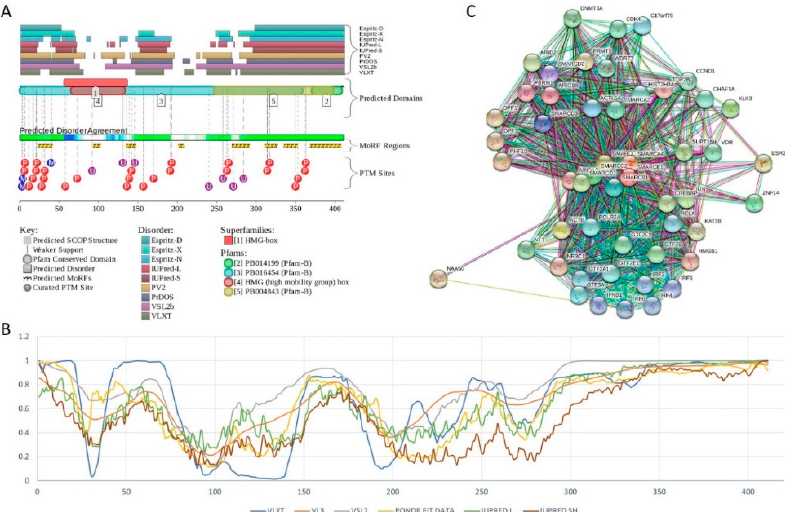
Figure 12. Structural and functional analysis of the human BAF57 protein (UniProt ID: Q969G3). ( A ) D 2 P 2 functional disorder profile of human BAF57 protein. ( B ) Intrinsic disorder profile of human BAF57 protein generated by six commonly used predictors of intrinsic disorder (PONDR ® VLXT, PONDR ® VL3, PONDR ® VSL2, PONDR ® FIT, IUPred_short, and IUPred_long). ( C ) STRING-generated protein–protein interaction network of human BAF57.